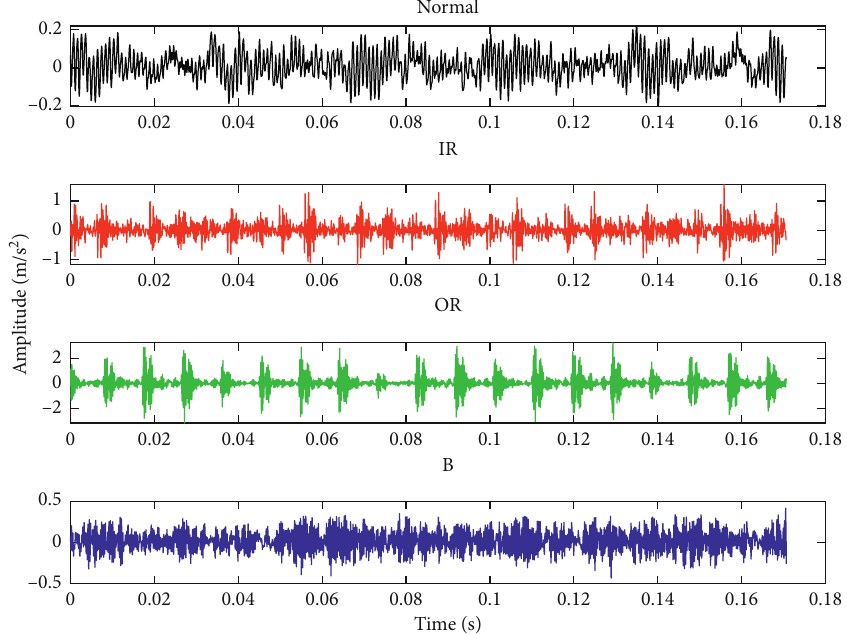
Figure 3: Time-domain diagram of each status signal. Table 2: Classification results of different